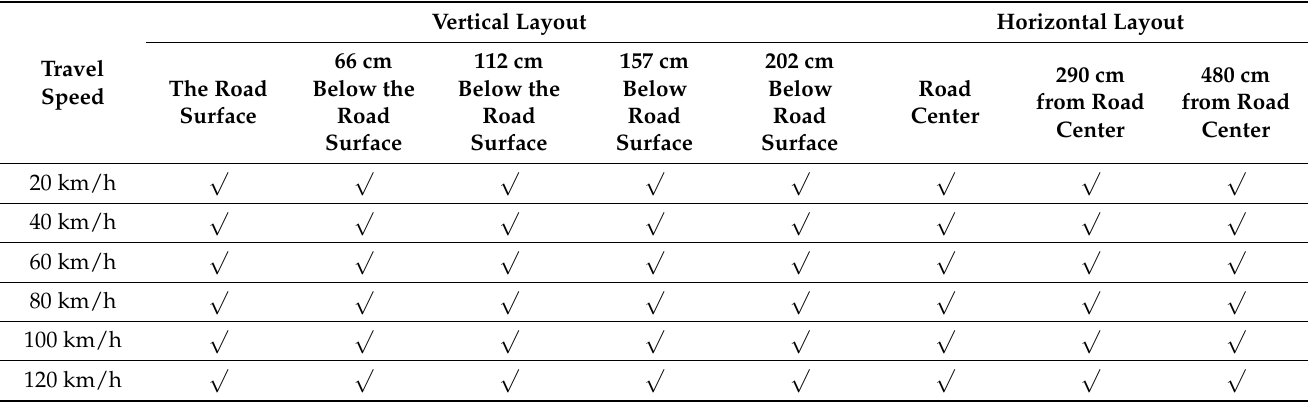
Table 2. Scheme 1 test location and working condition table.